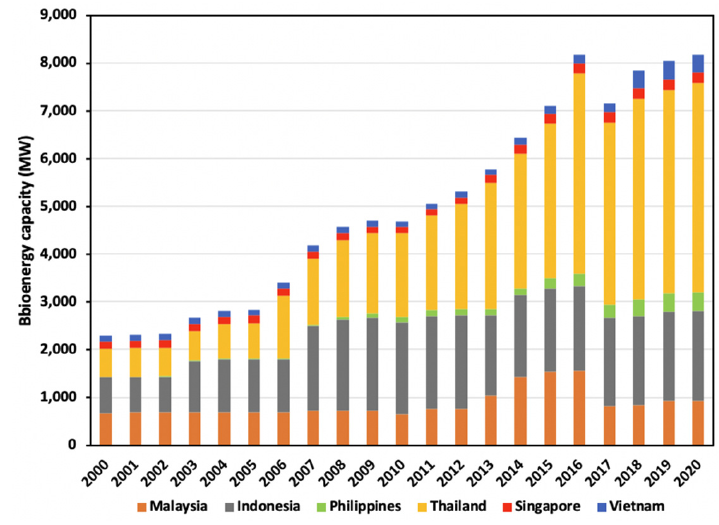
Figure 12. History of installed bioenergy capacity in ASEAN [22] .